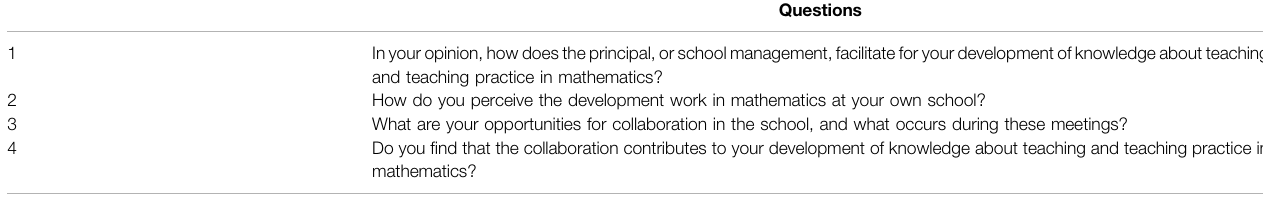
TABLE 3 | Structure of the focus-group interview guide for the mathematics teachers, fall 2019.